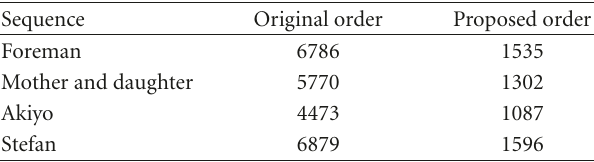
Table 2: Number of nonpipelined blocks in a